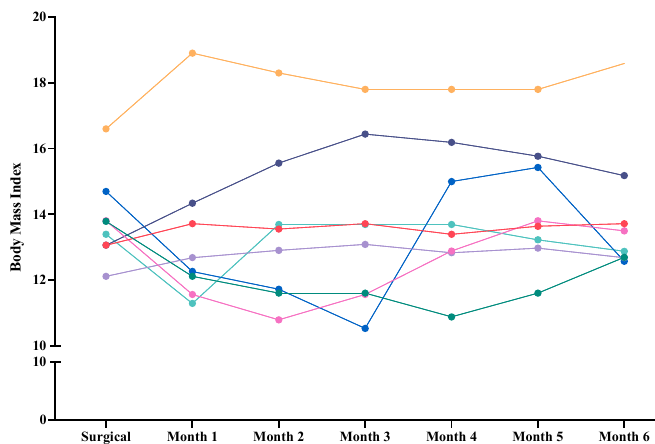
Figure 3. Individual changes in body mass index (BMI) during the six month follow-up period. BMI at surgery (criterion 1) was used as the reference value for this comparison.